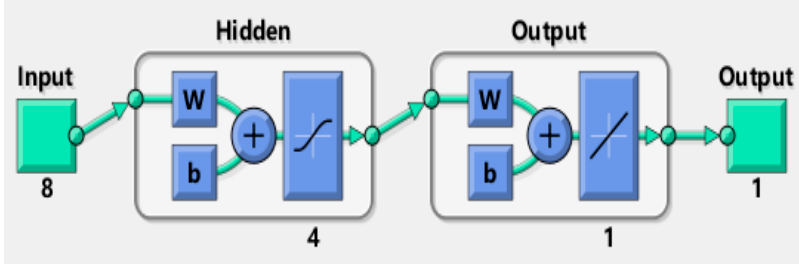
Figure 9. ANN structure for NPSHr objective.